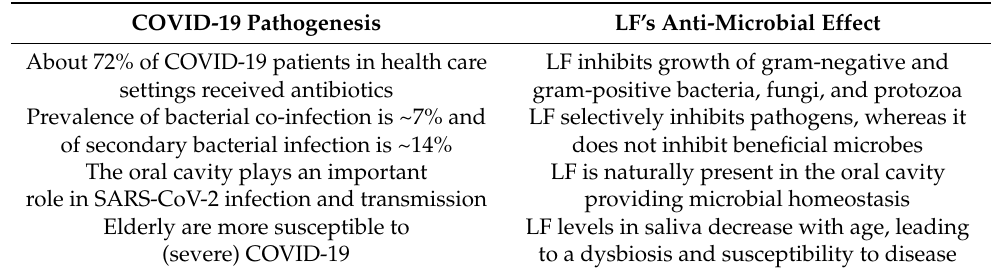
Table 3. Physiological effects as part of COVID-19 pathogenesis (left column) and corresponding anti-microbial effects of LF (right